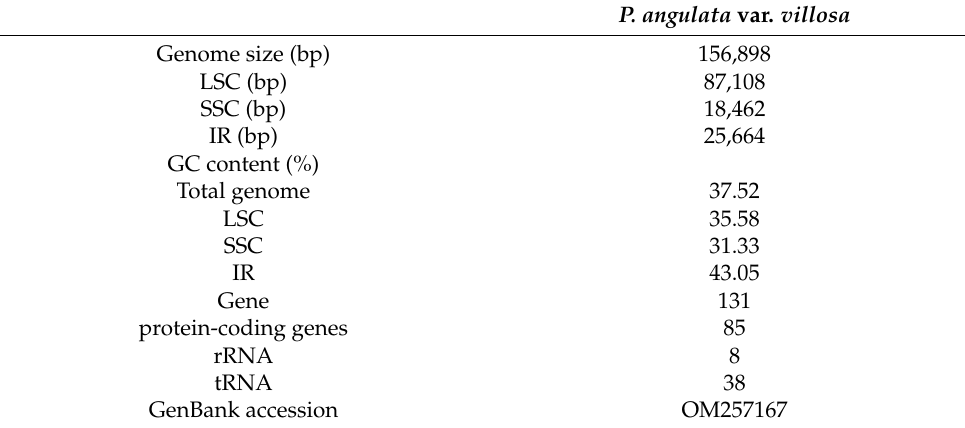
Table 1. Summaries of complete plastome of P. angulata var. villosa .